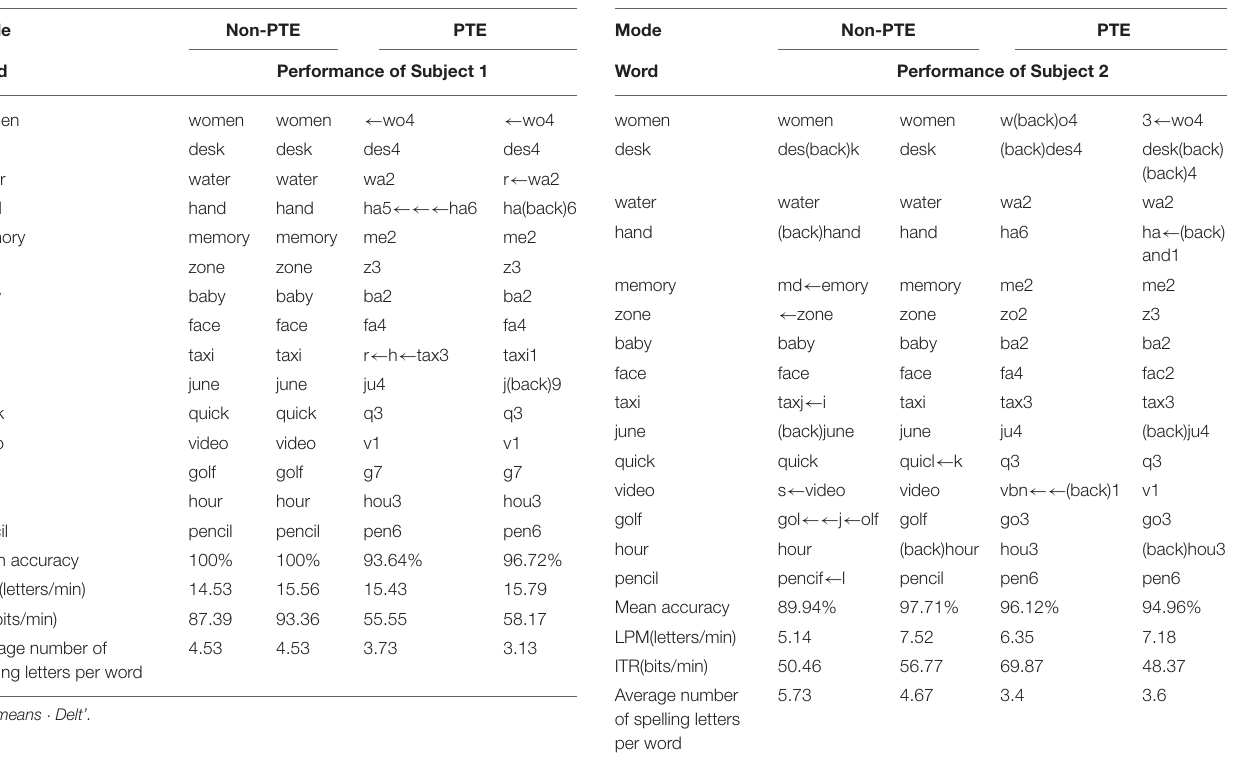
TABLE 4 | The detailed performance of character input for Subject 1. TABLE 5 | The detailed performance of character input for Subject